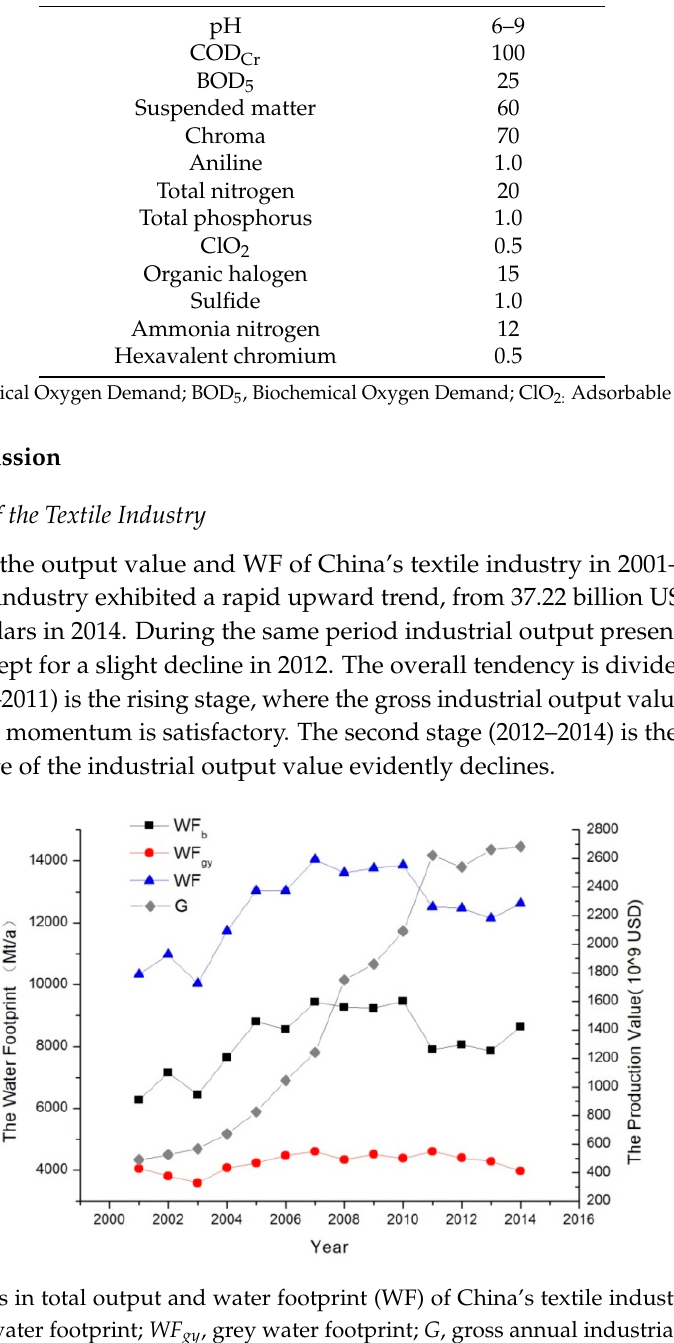
Table 4. Decoupling of WF and economic growth in China’s textile industry (2002–2014).